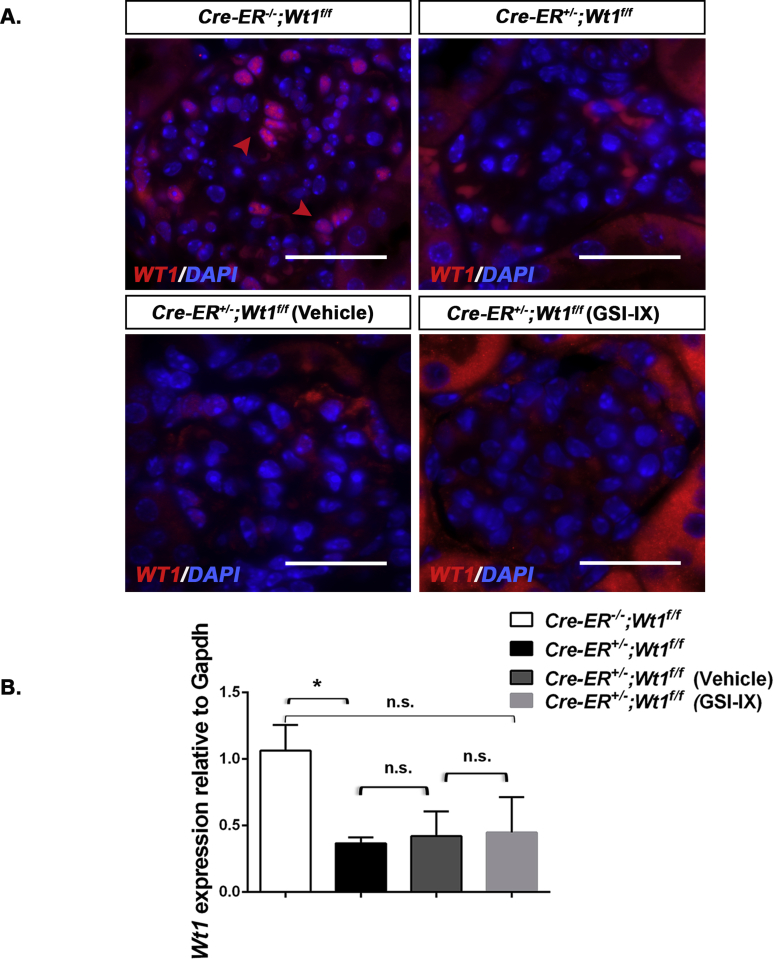
Wt1 expression is unchanged in Vehicle versus GSI-IX-treated CAGG-CreERTM+/–; Wt1f/f transgenic mice. (A) Shown are merged micrographs of kidney sections following immunofluorescent labeling of kidney tissue sections of CAGG-CreERTM–/–; Wt1f/f, CAGG-CreERTM+/–; Wt1f/f, vehicle versus GSI-IX-treated CAGG-CreERTM+/–; Wt1f/f transgenic mice with Wt1 (Alexa Fluor 594-conjugated secondary antibody). Scale bars = 50 μm. (B) Relative transcript levels of Wt1 in primary podocytes of CAGG-CreERTM−−;Wt1f/f (control), CAGG-CreERTM+/−;Wt1f/f (mutant), vehicle-treated CAGG-CreERTM+/−;Wt1f/f, and GSI-IX–treated CAGG-CreERTM+/−;Wt1f/f transgenic mice. Bars represent the mean, error bars represent the SEM. CAGG-CreERTM−/−;Wt1f/f versus CAGG-CreERTM+/−;Wt1f/f: 1.1 ± 0.2 versus 0.4 ± 0.4, *P = 0.03, Student t-test; CAGG-CreERTM−/−;Wt1f/f versus vehicle-treated CAGG-CreERTM+/−;Wt1f/f mice: 1.1 ± 0.2 versus 0.4 ± 0.2, P = 0.07, Student t-test; vehicle-treated CAGG-CreERTM+/−;Wt1f/f mice versus GSI-IX–treated CAGG-CreERTM+/−;Wt1f/f transgenic mice: 0.4 ± 0.2 versus 0.4 ± 0.3, P = 0.93, Student t-test. n.s., not significant.